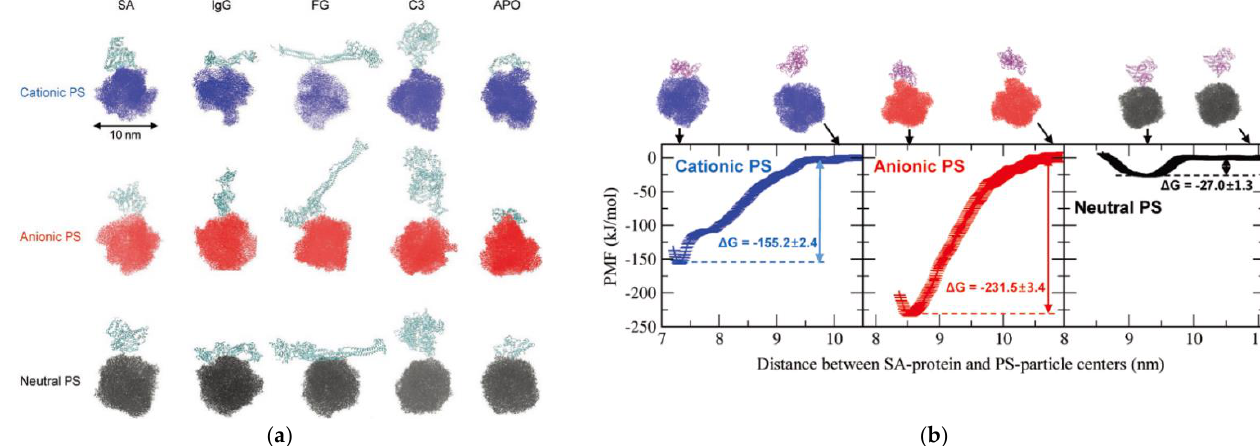
Figure 7. ( a ) Final snapshot of simulations of the binding between differently charged polystyrene (PS) nanoparticles and major plasma proteins such as HSA, immunoglobulin G (IgG), FG, complement 3 (C3), and apolipoprotein (APO), ( b ) calculations of potentials of mean force (PMF; binding free energies) between HSA and differently charged PS nanoparticles. Reproduced with permission from [57], WILEY-VCH, 2020.